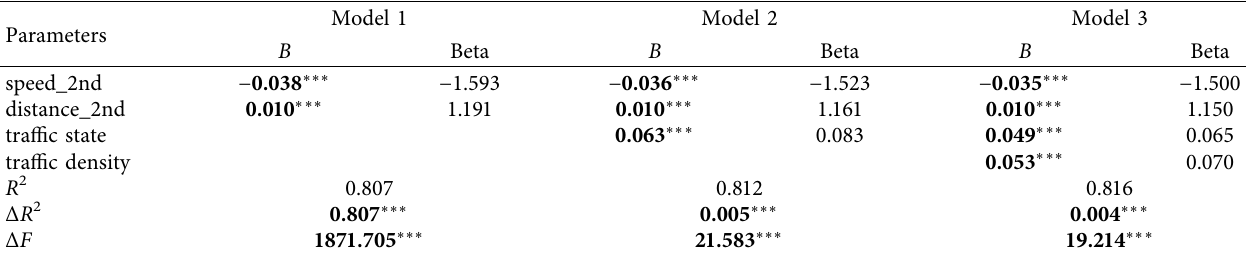
Table 5: Regression analysis results of the average deceleration.